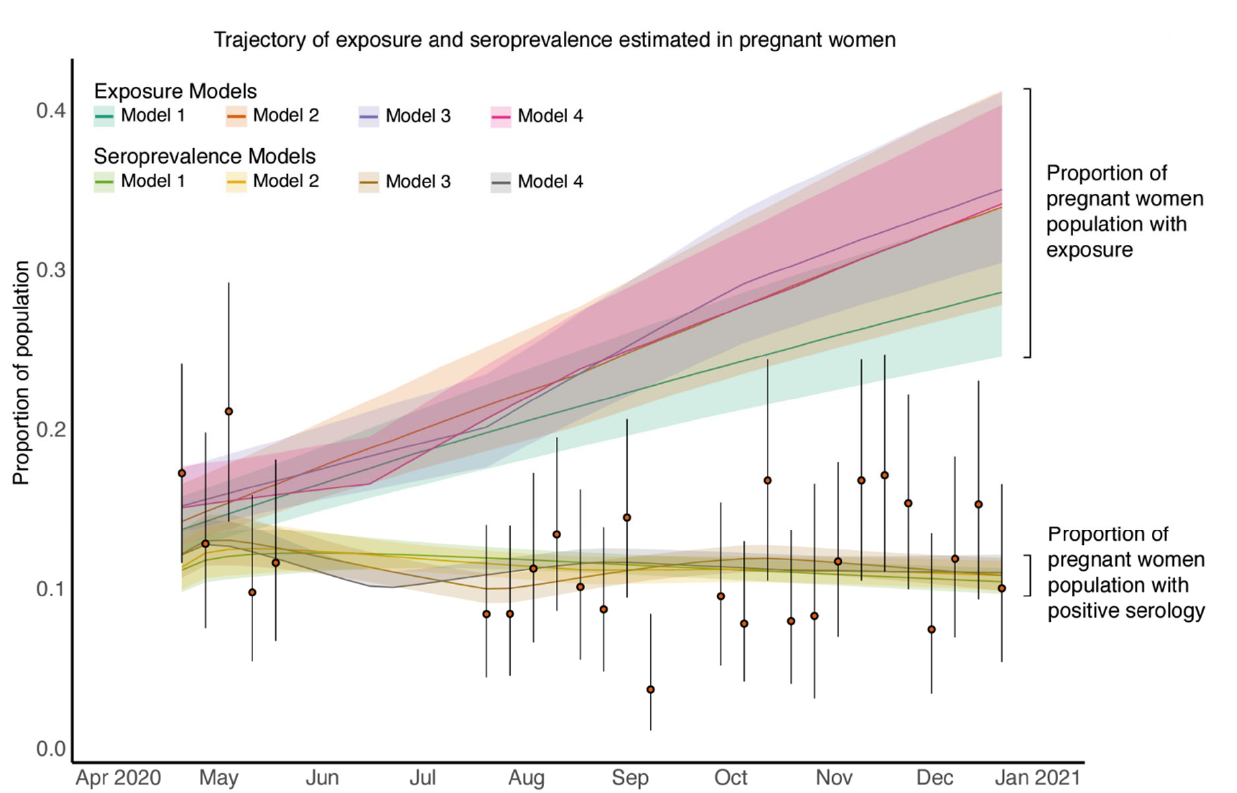
Figure 3. Time evolution of SARS-CoV-2 exposure and seroprevalence among patients who gave birth between 20 April 2020 and 21 December 2020. The orange solid circles and black error bars represent the measured proportion of patients who were giving birth and serology positive and their credible intervals respectively. The green, orange, purple and pink lines show the median es ‐ timates of exposure for patients who were giving birth from Model 1, Model 2, Model 3 and Model 4 respectively; shaded areas correspond to 90% credible intervals. The light green, yellow, brown and grey lines show the median estimates of seroprevalence for patients who were giving birth from Model 1, Model 2, Model 3 and Model 4 respectively; shaded areas correspond to 50% credible in ‐ tervals.